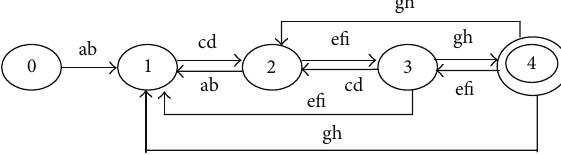
Figure 5: DFA illustrating regular expression.